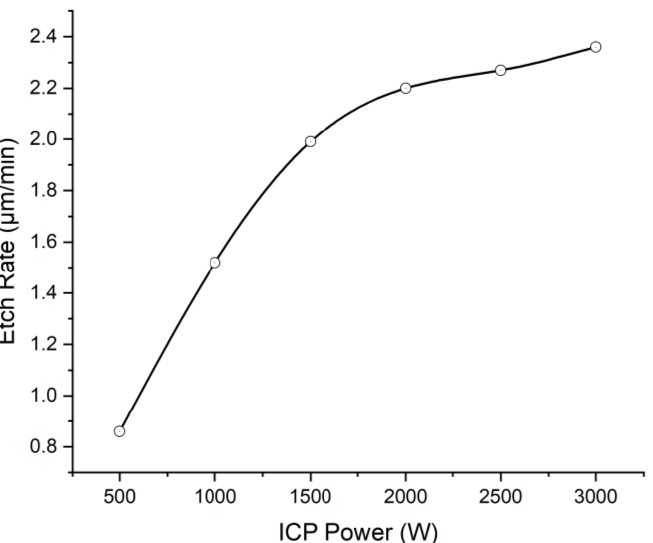
Figure 3. The relationship between etch rate and ICP power under 500 W RF power, 10% CHF 3 gas composition, and 100 sccm etch gas flow speed.